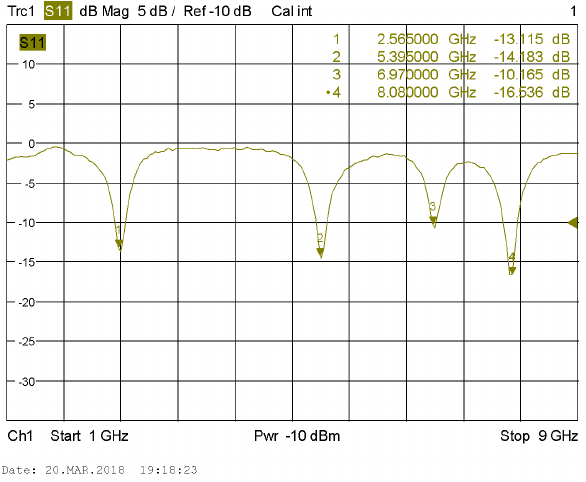
Figure 8. Measured S 11 result The simulated and measured VSWR of the proposed configuration is illustrated in Figure 9 and 10 respectively. The antenna has VSWR between 1-2 for the entire four band of operation.